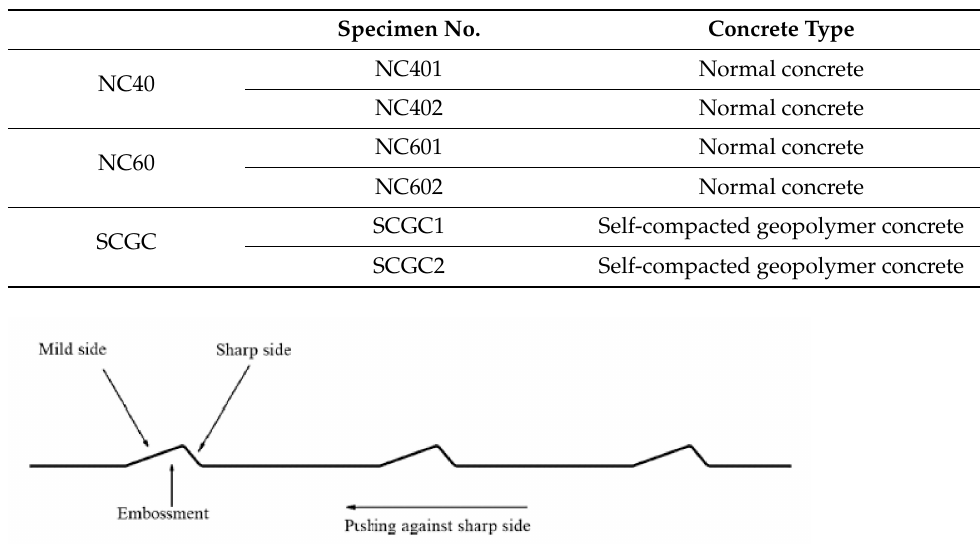
Figure 4. Indication of mild and sharp sides of the embossment.